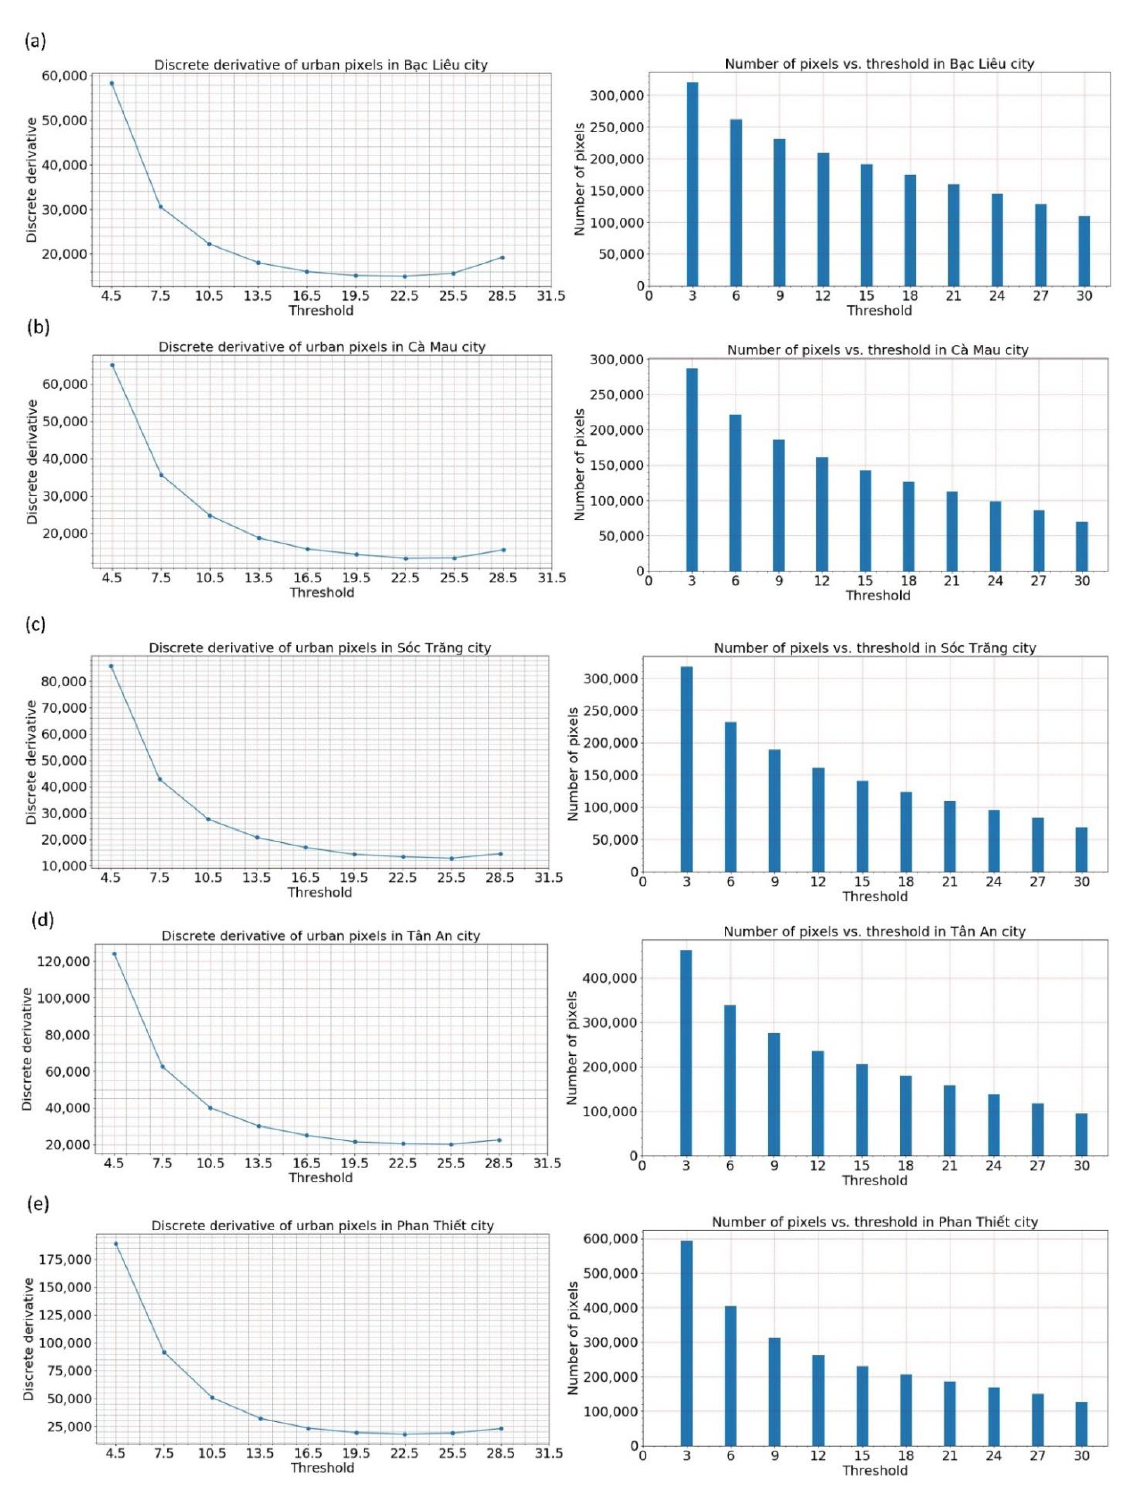
Figure A1. Discrete derivative of building pixel vs. threshold in ( a ) Bạc Liêu, ( b ) Cà Mau, ( c ) Sóc Trăng, ( d ) Tân An, and ( e ) Phan Thiết.